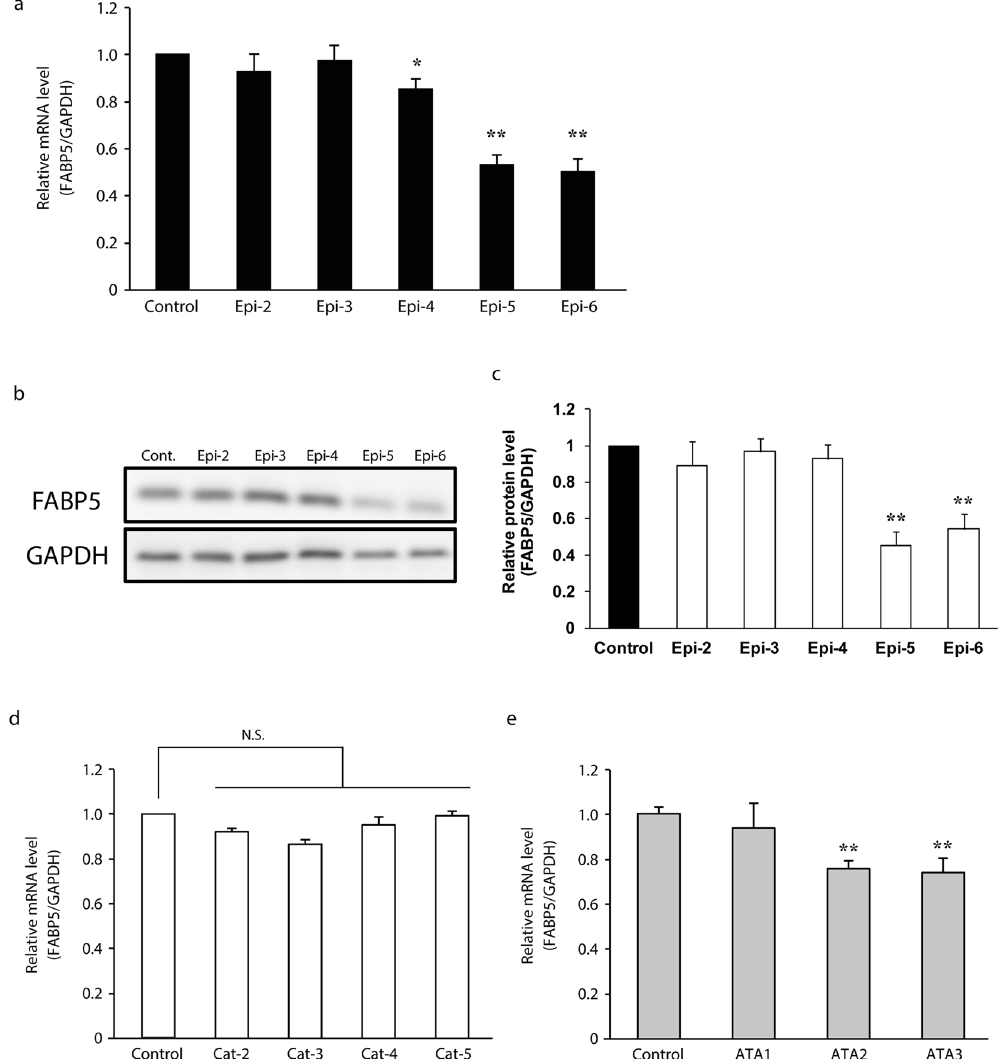
Figure 7. Effects of test compounds on the expression of the cancer-promoting gene FABP5 . Of test oligomeric compounds (50 μ mol/L), epicatechin pentamer (Epi-5) strongly suppressed the FABP5 gene expression in PC-3 cells. The experimental procedure for preparation of test compounds was described in Biochemical methods of Supplementary Information. The cells treated with test compounds, epicatechin [dimer (Epi-2), trimer (Epi-3), tetramer (Epi-4), pentamer (Epi-5) and hexamer (Epi-6)] ( a , b and c ), catechin [dimer (Cat-2), trimer (Cat-3), tetramer (Cat-4) and pentamer (Cat-5)] ( d ), arecatannin A1 (ATA1), arecatannin A2 (ATA2), or arecatannin A3 (ATA3) ( e ) for 48 h were collected and the FABP5 mRNA level was determined by qPCR ( a , d and e ). Whole cell lysates were prepared and subjected to western blotting. Western blot analysis of FABP5 protein levels was determined after treatment of PC-3 cells with epicatechin [dimer (Epi-2), trimer (Epi-3), tetramer (Epi-4), pentamer (Epi-5) and hexamer (Epi-6)] ( b and c ). The quantification of FABP5 protein levels by densitometric measurement using Image J software (NIH) ( c ). The data of qPCR and densitometric data from western blot analysis are the means ± S.D. of three independent experiments, and one-way ANOVA followed by Tukey’s multiple comparison test was used to compare means. * P < 0.05 or ** P < 0.01. The data of Western blot analysis are representative of three independent